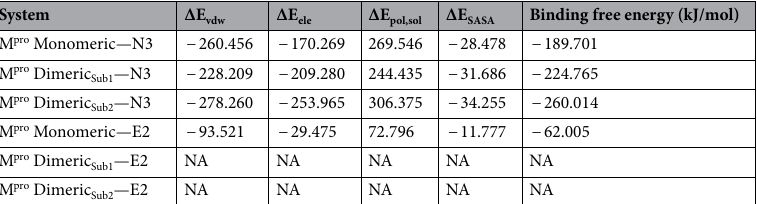
Table 1. The result of binding free energy calculated by MM/PBSA methods for N3 inhibitor and E2 with the main protease (monomeric and dimeric states) during the last 10 ns of MD simulation.